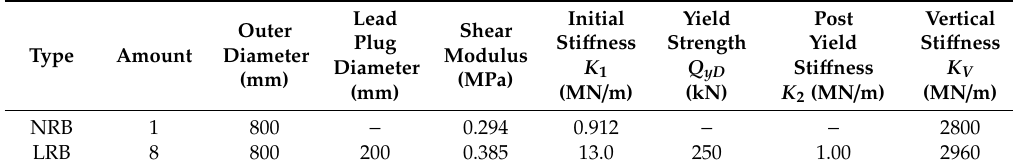
Table 3. Properties of selected isolators for Model-05.